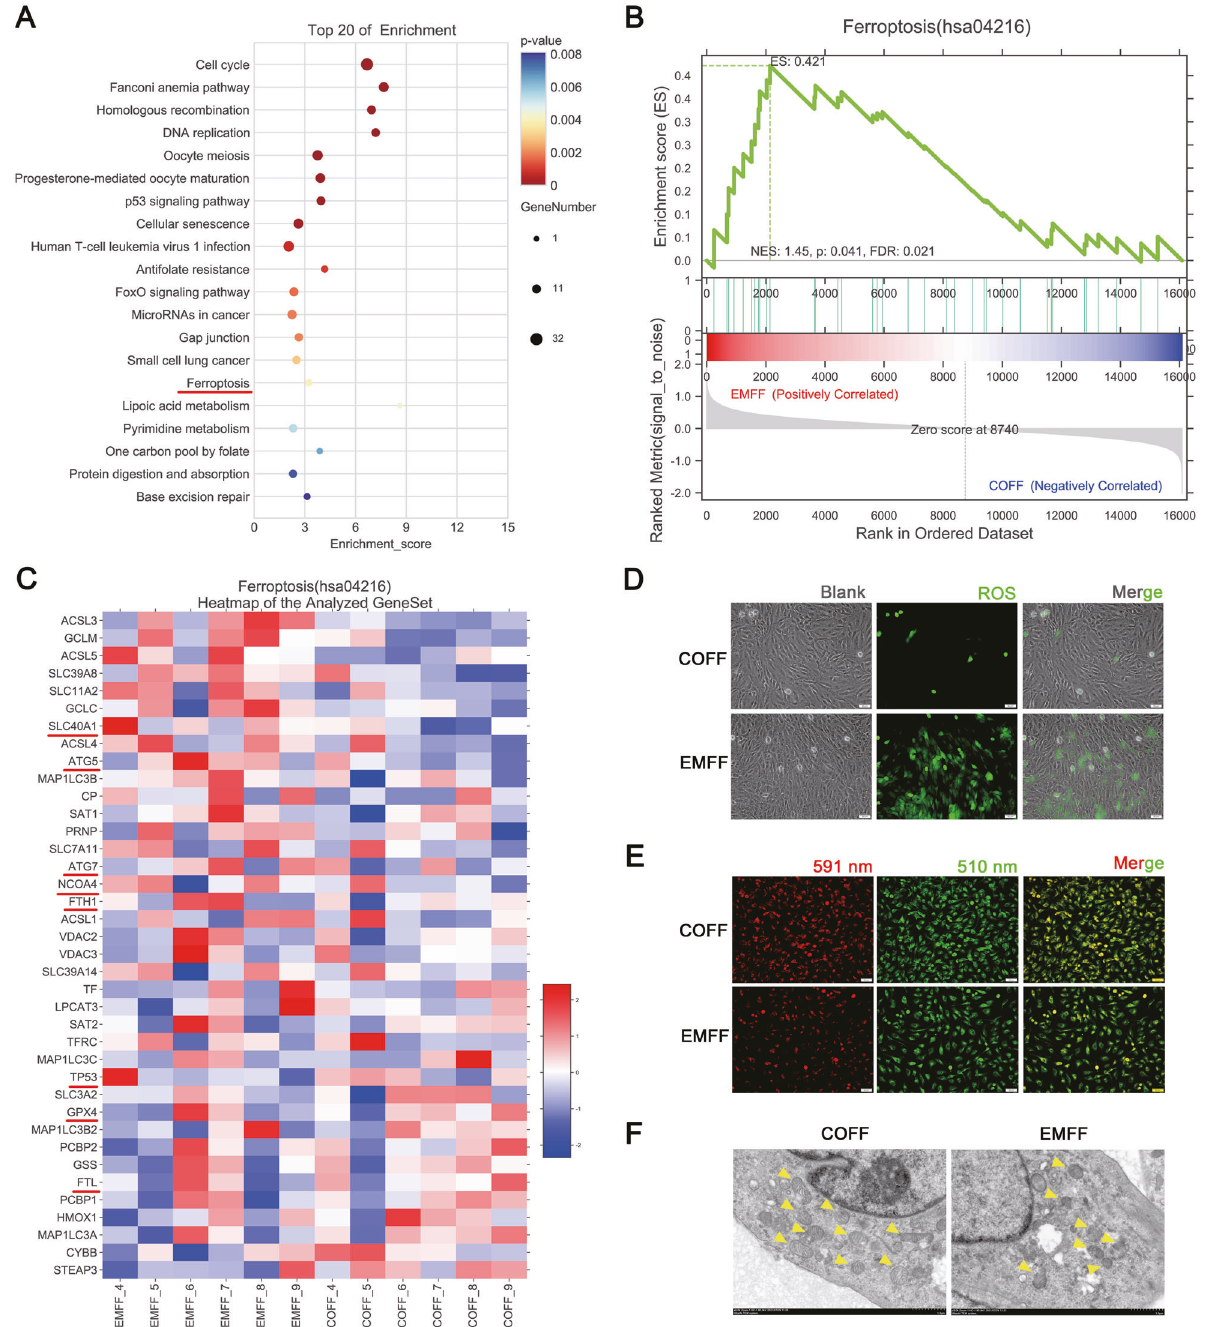
Fig. 1 EMFF-induced granulosa cell ferroptosis. A KEGG enrichment top 20 bubble plot of KGN after EMFF treatment. The horizontal axis in the plot is the enrichment score. The larger the bubble, the greater the number of differential genes included. The lower the enrichment P value is, the higher the degree of signi fi cance. B GSEA analysis plot. Each line in the middle part of the fi gure represents one gene in the gene set and its ranked position in the gene list. The bottom part is a matrix of gene-phenotype associations, with red being positively correlated with EMFF and blue being positively correlated with COFF. FDR < 0.25 was set as credible enrichment. C Heatmap of transcript differential protein-coding genes (fold change > 2) between EMFF-KGN ( n = 6) and COFF-KGN ( n = 6). Red indicates relatively high expression protein- coding genes, and blue indicates relatively low expression protein-coding genes. D Representative images of ROS levels of EMFF-KGN and COFF-KGN under fl uorescence staining. The green markers represent ROS level. Scale bar = 50 µm. E Representative images of C11-BODIPY (581/591) staining in EMFF-KGN and COFF-KGN groups. 591 nm represents the reduction state and 510 nm represents the oxidation state. Scale bar = 50 µm. F The mitochondrial morphology of COFF-KGN and EMFF-KGN was observed by TEM. Yellow arrows indicate mitochondrion. Scale bar = 1.0